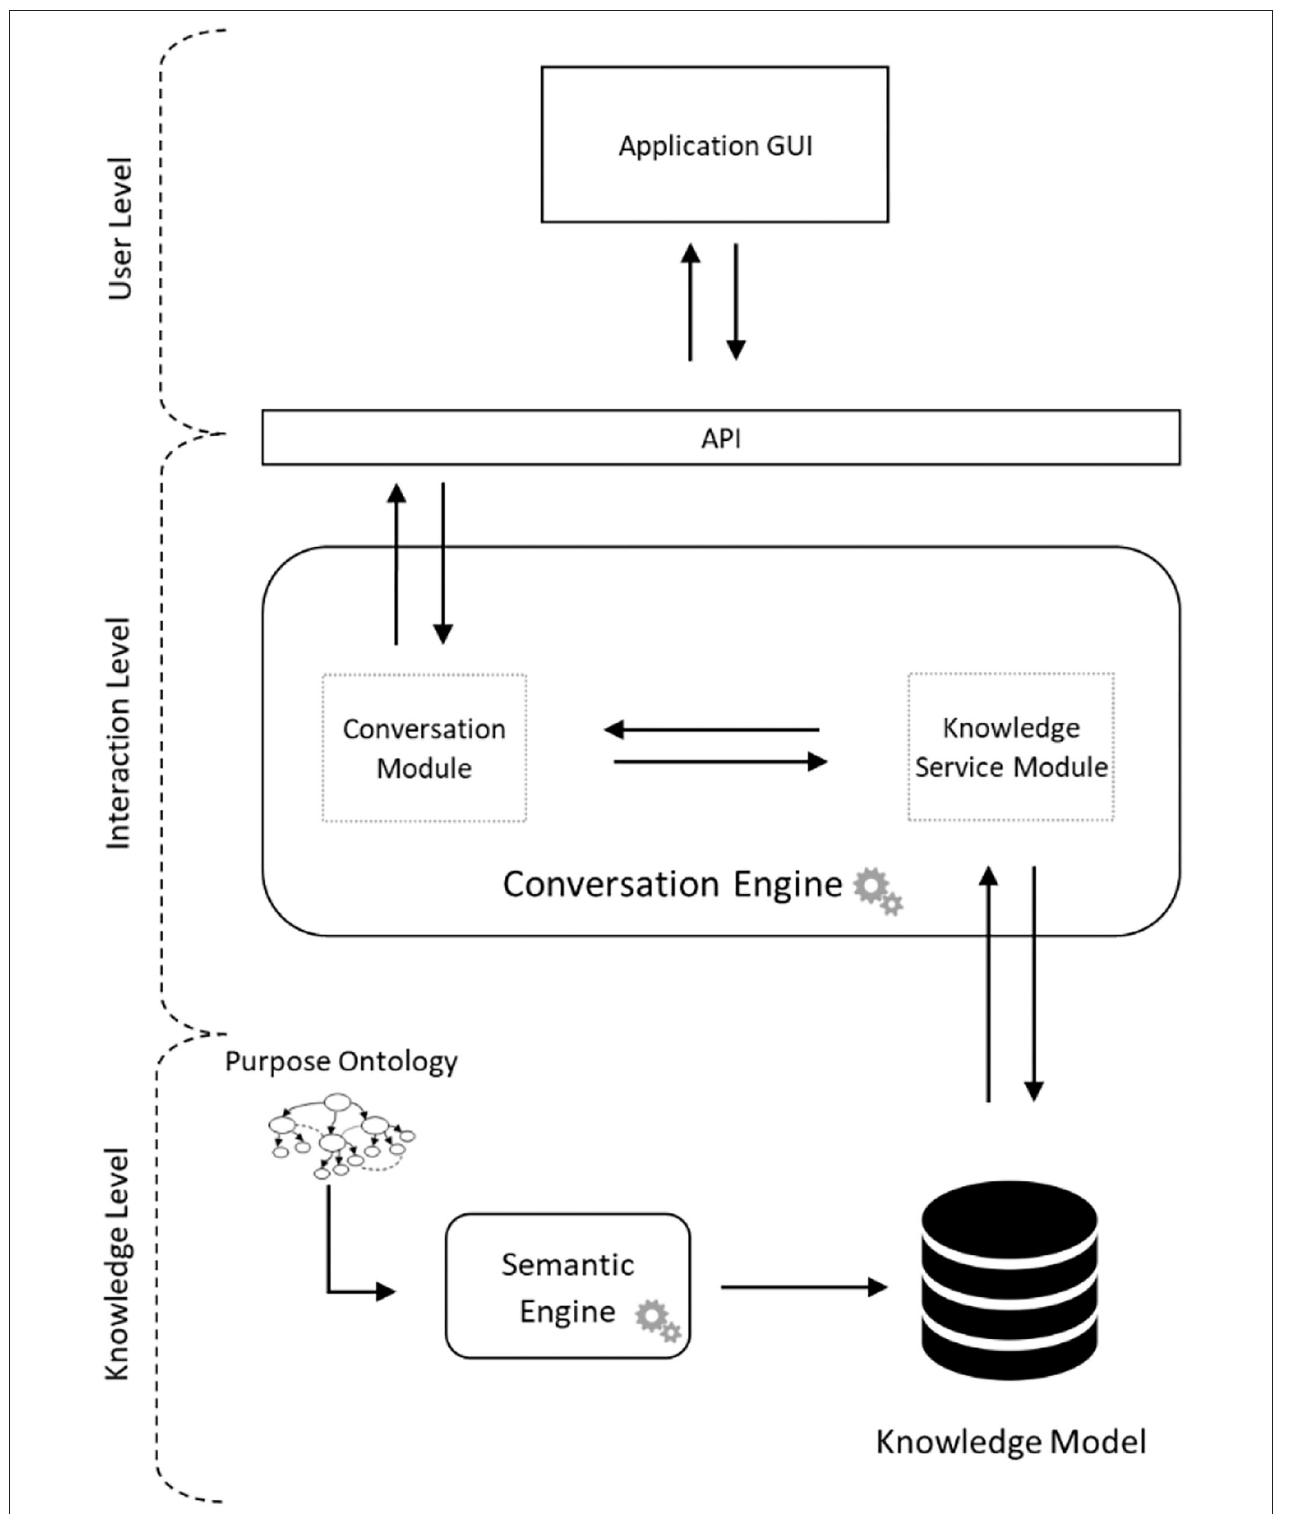
FIGURE 1 | System